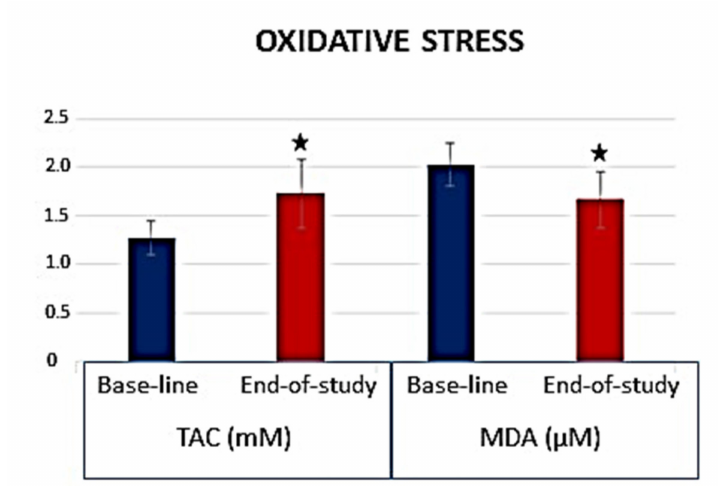
Figure 5. Parameters of Oxidative Stress in Chufa de Valencia intake, determined by TAC and MDA/TBARS. TAC: Total antioxidant capacity; MDA/TBARS: Malondialdehyde/thiobarbituric (cid:70) p acid reactive substances; < 0.05.